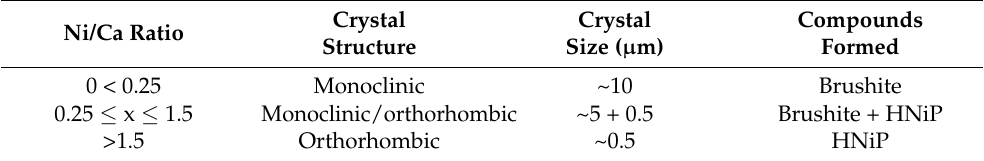
Crystal Structure